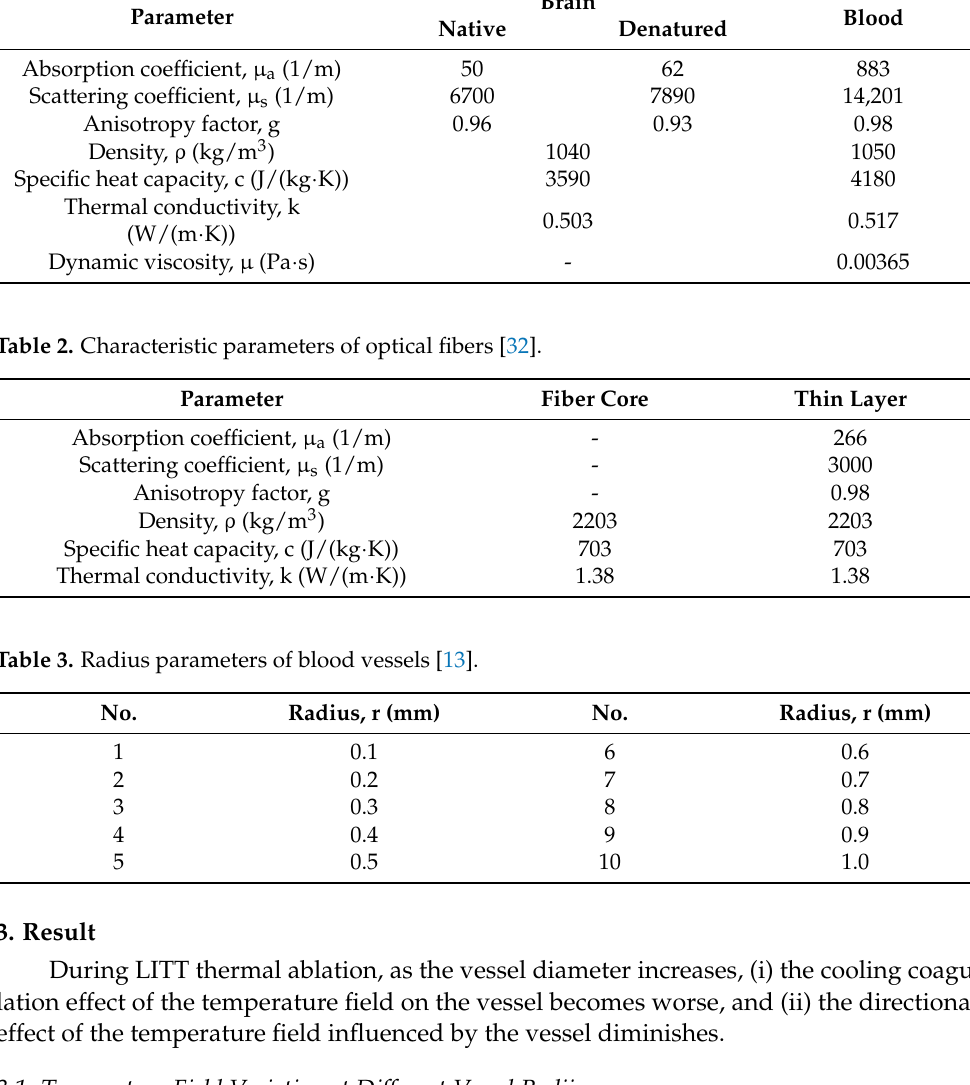
Table 1. Optical properties and thermal physical parameters of tissues and blood vessels [30,31]. Parameter